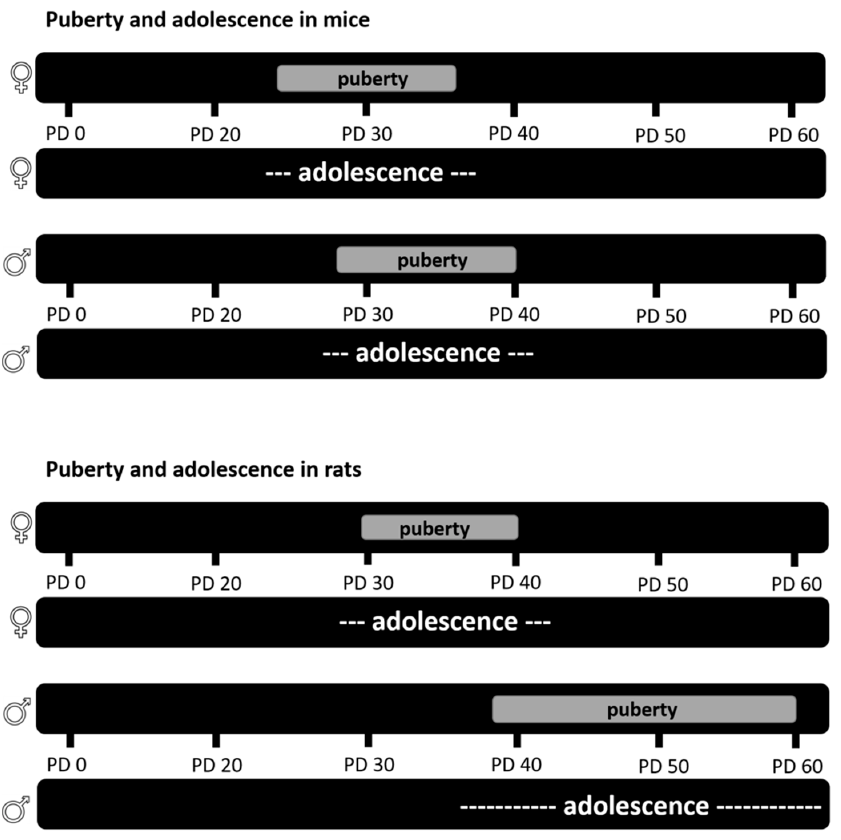
Figure 2. Puberty in male and female mice and rats. The timing of puberty and adolescence in male and female mice ( top ) and rats ( bottom ) (modified after [125]). PD = postnatal day.